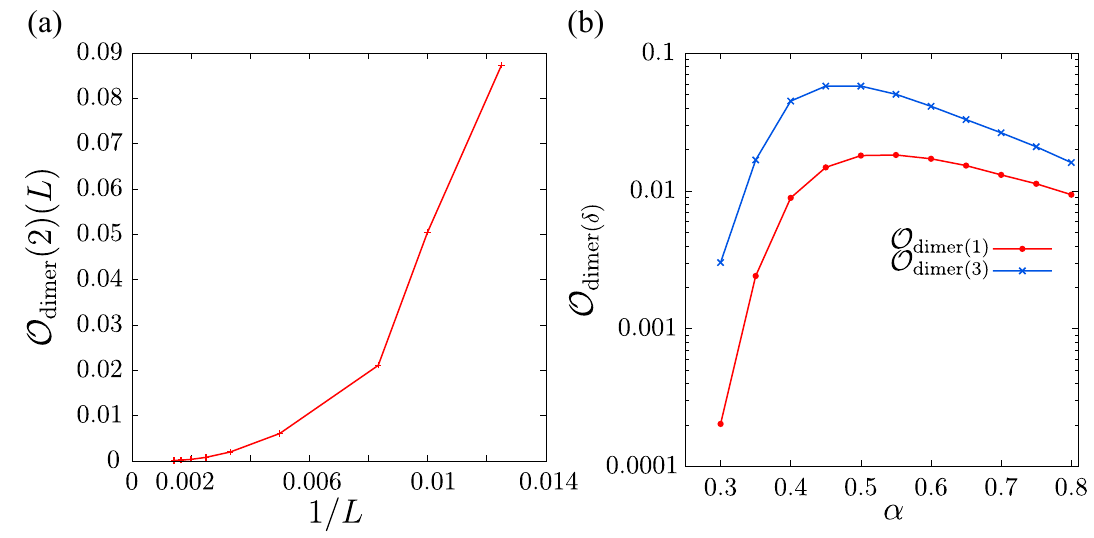
Figure 6: (a) Finite-size scaling of the dimer order parameter for NNN bonds ( δ = 2) at α = 0.6. The order parameter is vanishing in the thermodynamical limit. (b) Dimer order parameters for NN ( δ = 1, red line) and third-neighbor ( δ = 3, blue line) bonds as a function of α